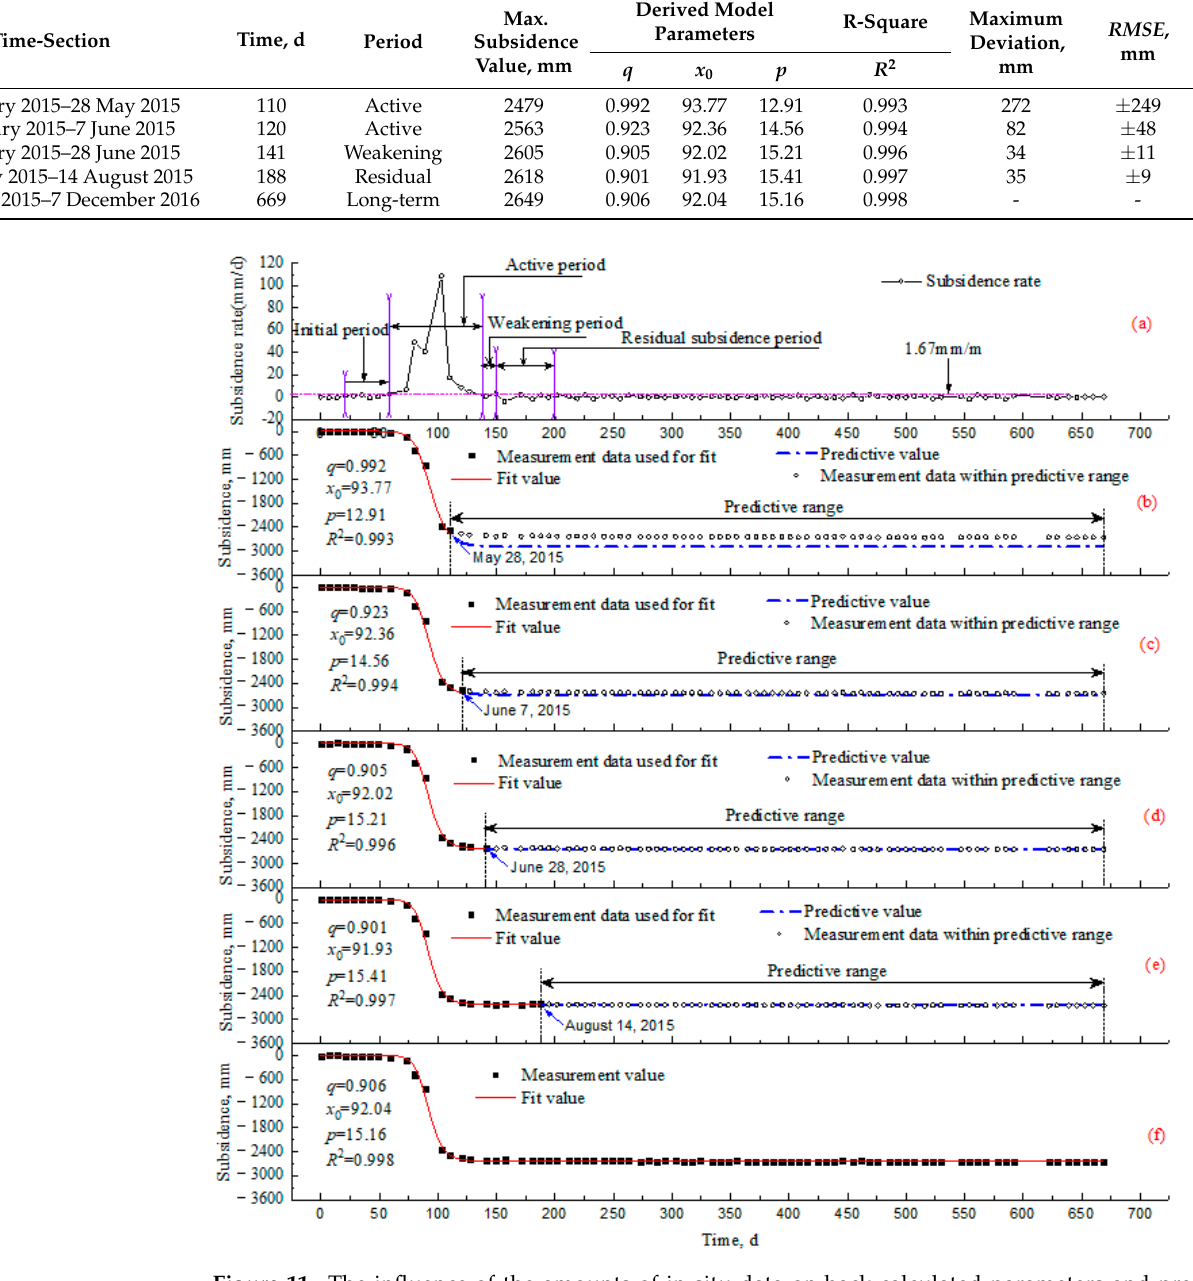
Figure 11. The influence of the amounts of in situ data on back-calculated parameters and predicted values: ( a ) subsidence rate curve, ( b , c ) represent stopping observation within active period, ( d ) presents stopping observation within weakening period, ( e , f ) show stopping observation within residual subsidence period and long-term subsidence period,